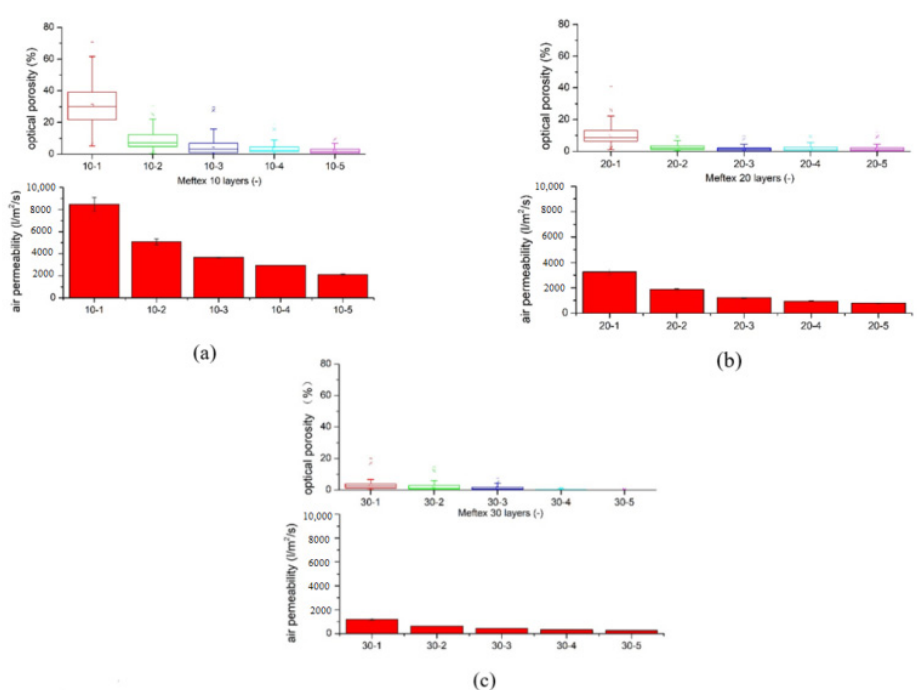
Figure 8. SEG value and relationship between SE and planner mass ( a ) MEFTEX 10 ( b ) MEFTEX 20 ( c ) MEFTEX 30.